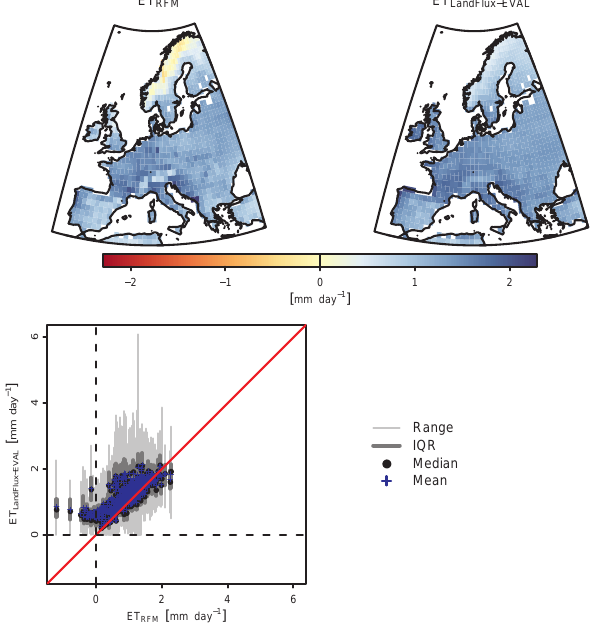
Figure 12. The 1976 drought in Europe. The top left panel shows the monthly runoff rate in June 1976. The top right panel shows the corresponding standardised runoff anomalies. The bottom panel shows the time series of the spatial average of standardised runoff anomalies for the entire region under